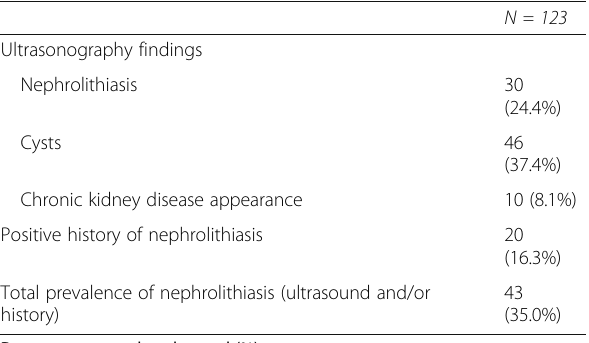
Table 2 Ultrasonography findings plus the prevalence of nephrolithiasis Ultrasonography findings